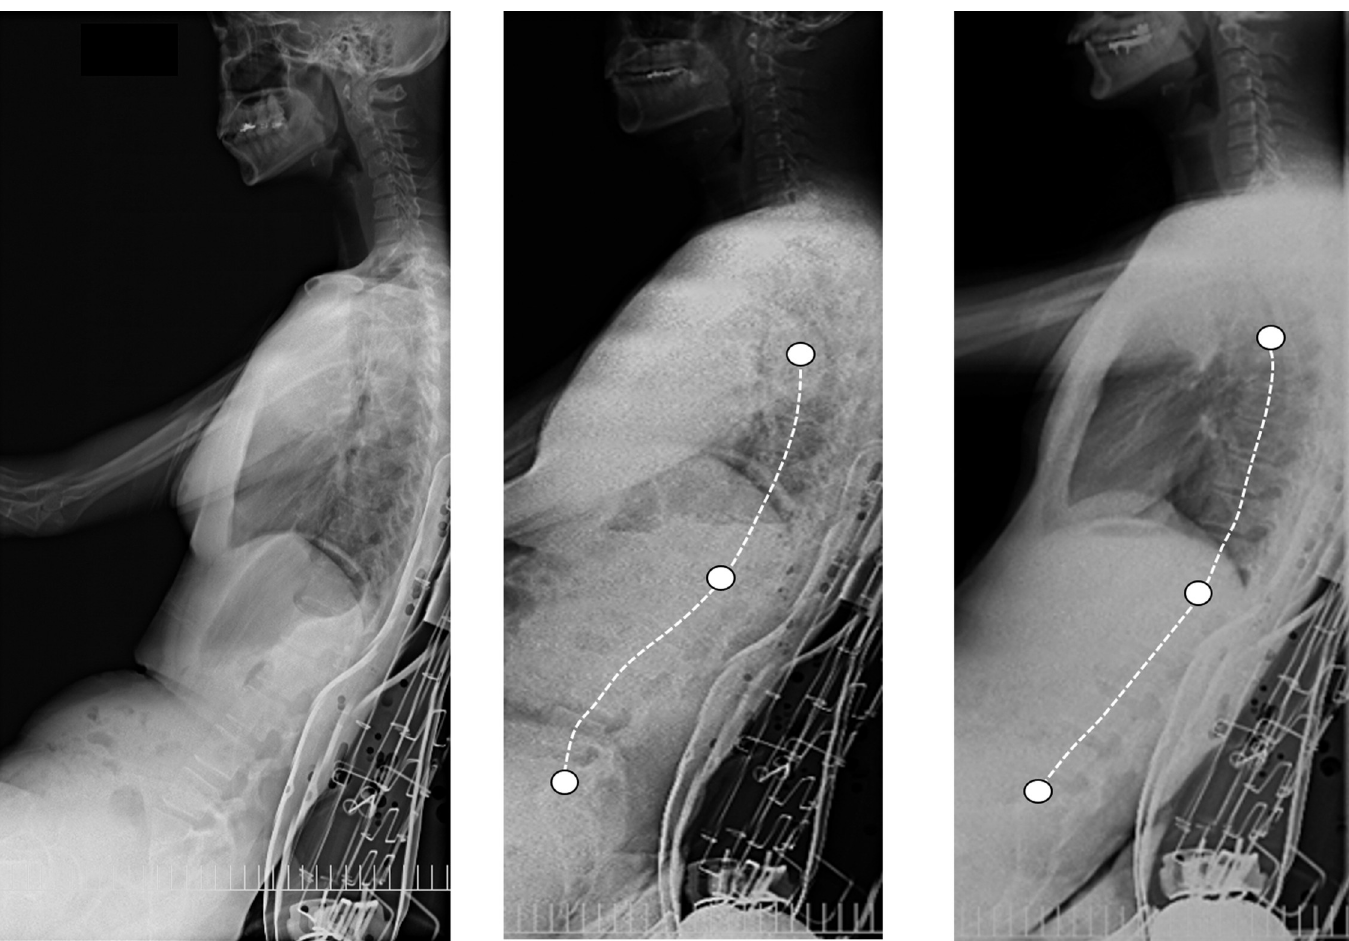
Fig 2. Lateral radiographs of three volunteers (left). There were volunteers with a lumbar lordosis (center) and volunteers with decreasing lumbar lordosis and pelvic tilt